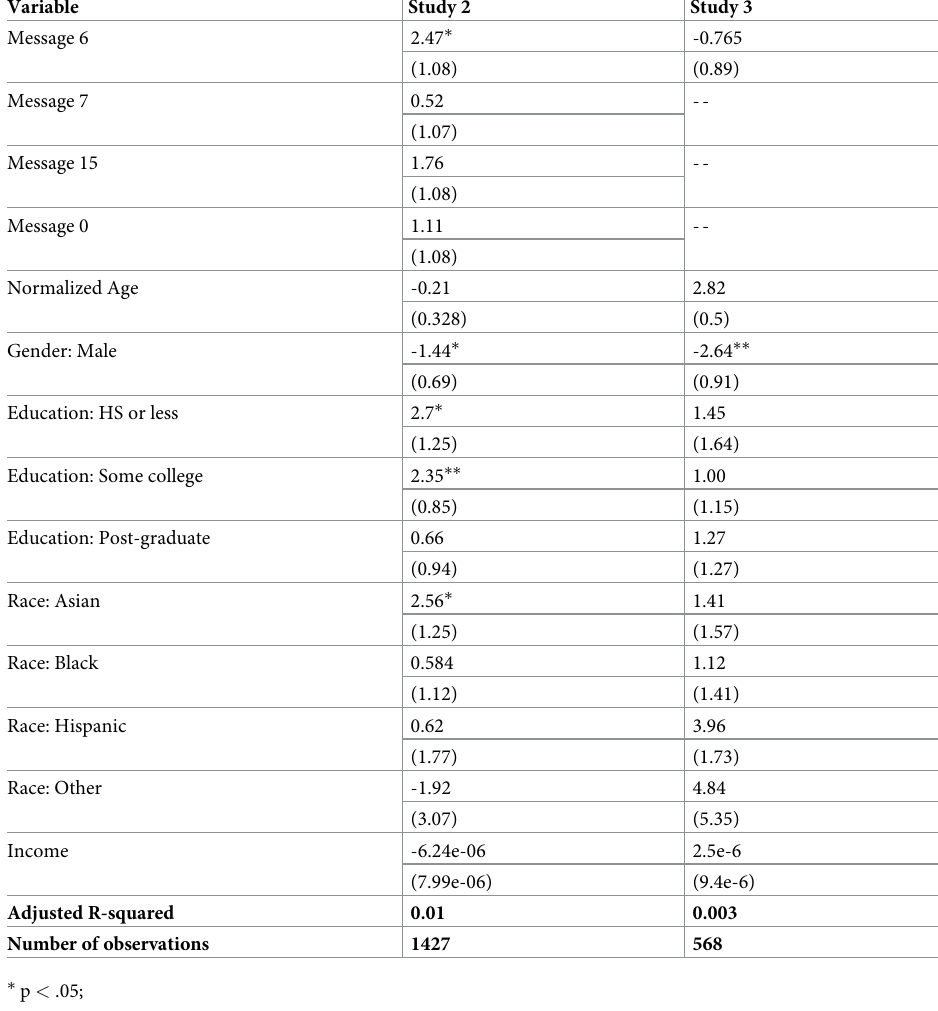
Table 3. Regression from Study 2 and 3, difference score (scale from 0–100) as outcome.